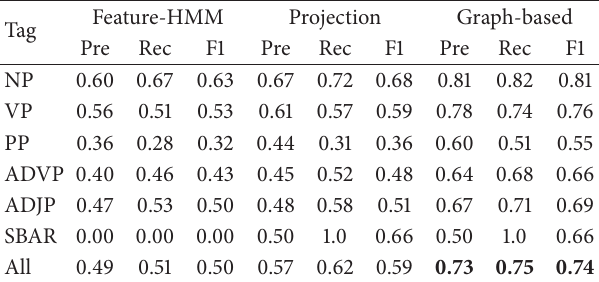
Table 5: Chunk tagging evaluation results for various baselines and proposed graph-based